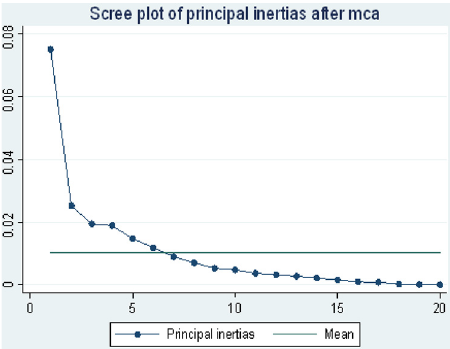
Table 1. Attributes